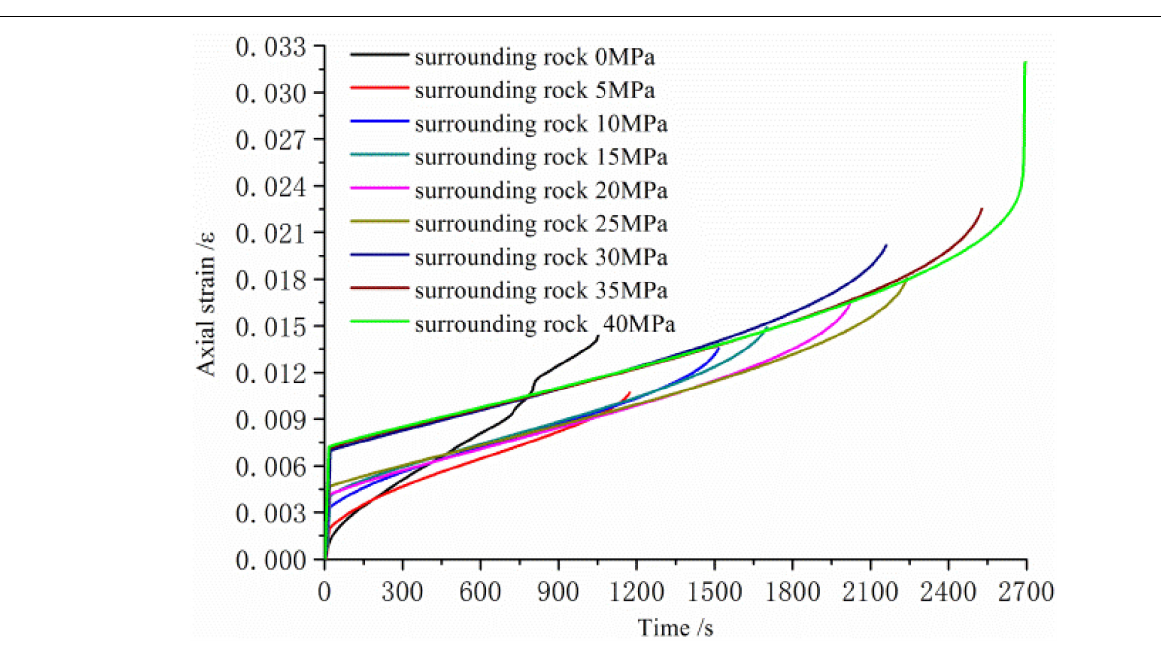
FIGURE 4 | Curves of axial strain vs. time for sandstone specimens under different confining